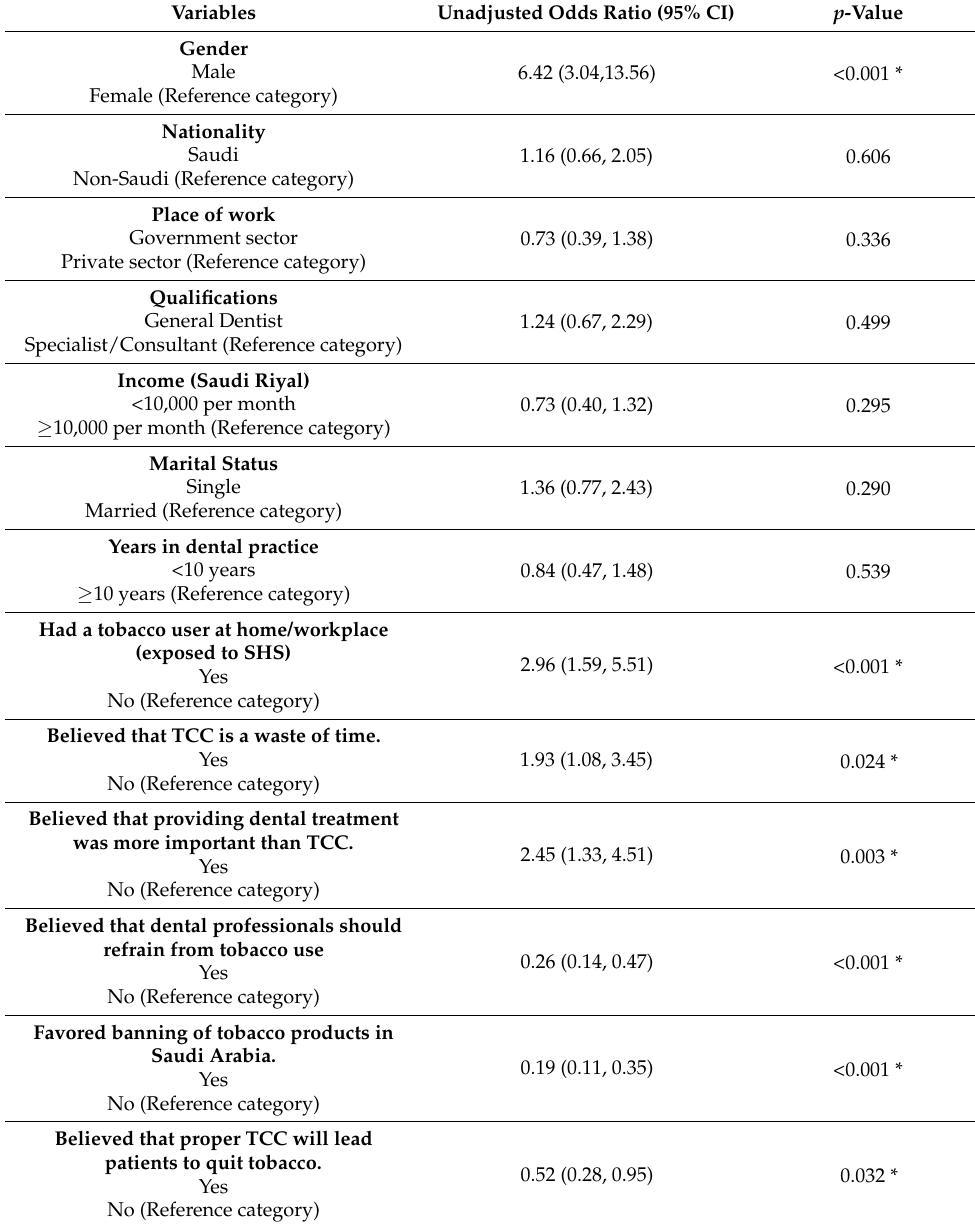
Table 2. Bivariate Analysis: Tobacco use among dental professionals and its relationship with study